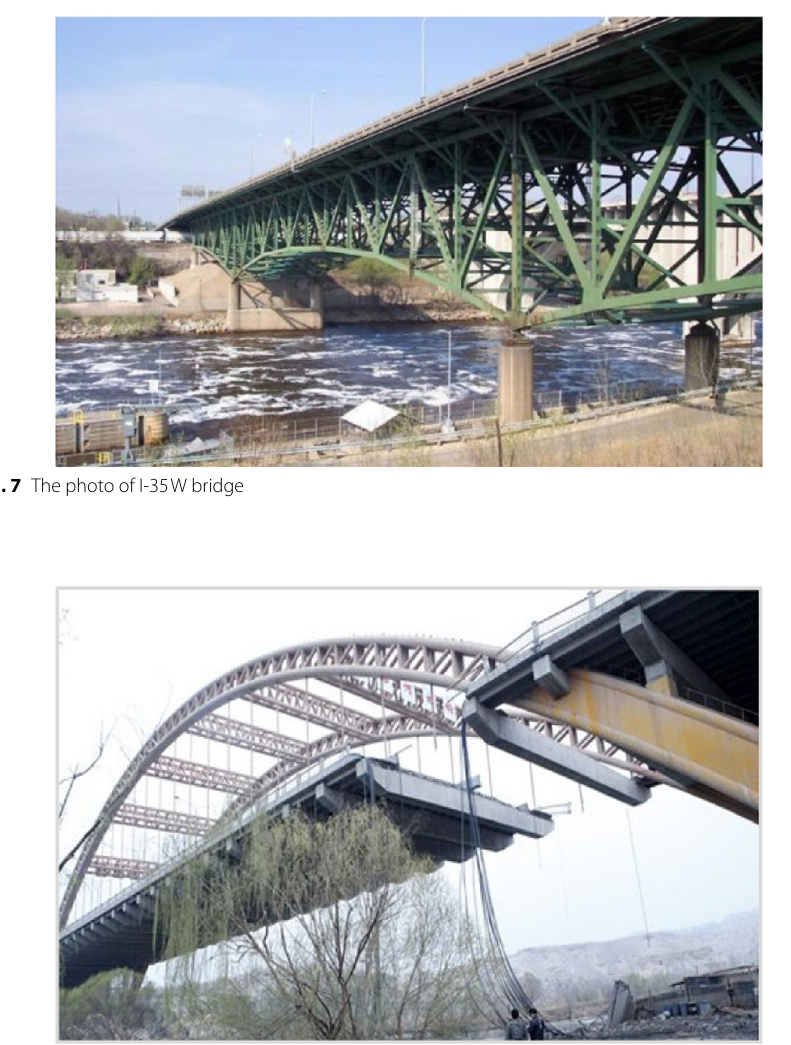
Fig. 8 The Xiaonanmen Bridge in